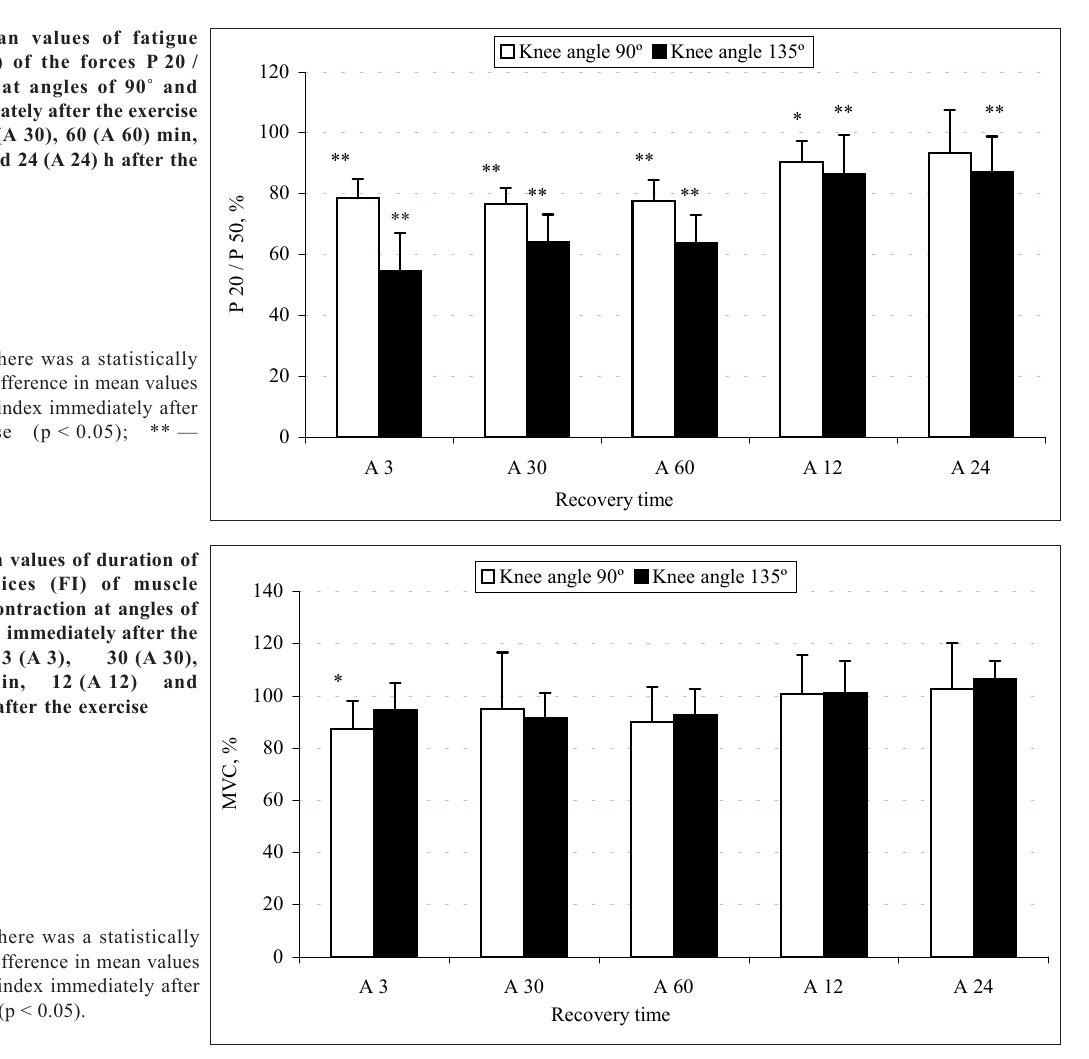
Fig. 6. Mean values of fatigue indices (FI) of the forces P 20 / P 50 ratio at angles of 90 ˚ and 135 ˚ immediately after the exercise 3 (A 3), 30 (A 30), 60 (A 60) min, 12 (A 12) and 24 (A 24) h after the